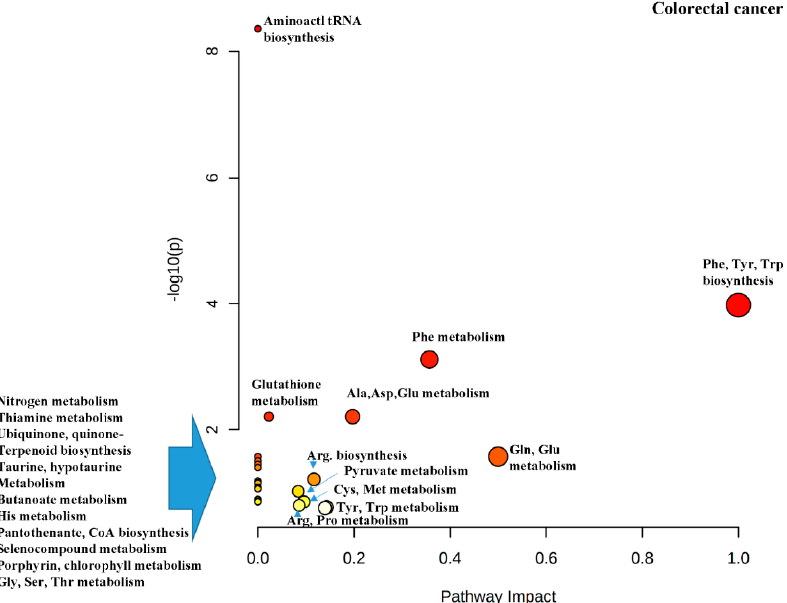
Figure 6. Pathway analysis performed using the altered metabolites from metabolomics data for colorectal cancer (CRC) (refer to the legend of Figure 4 for the diagram explanation).